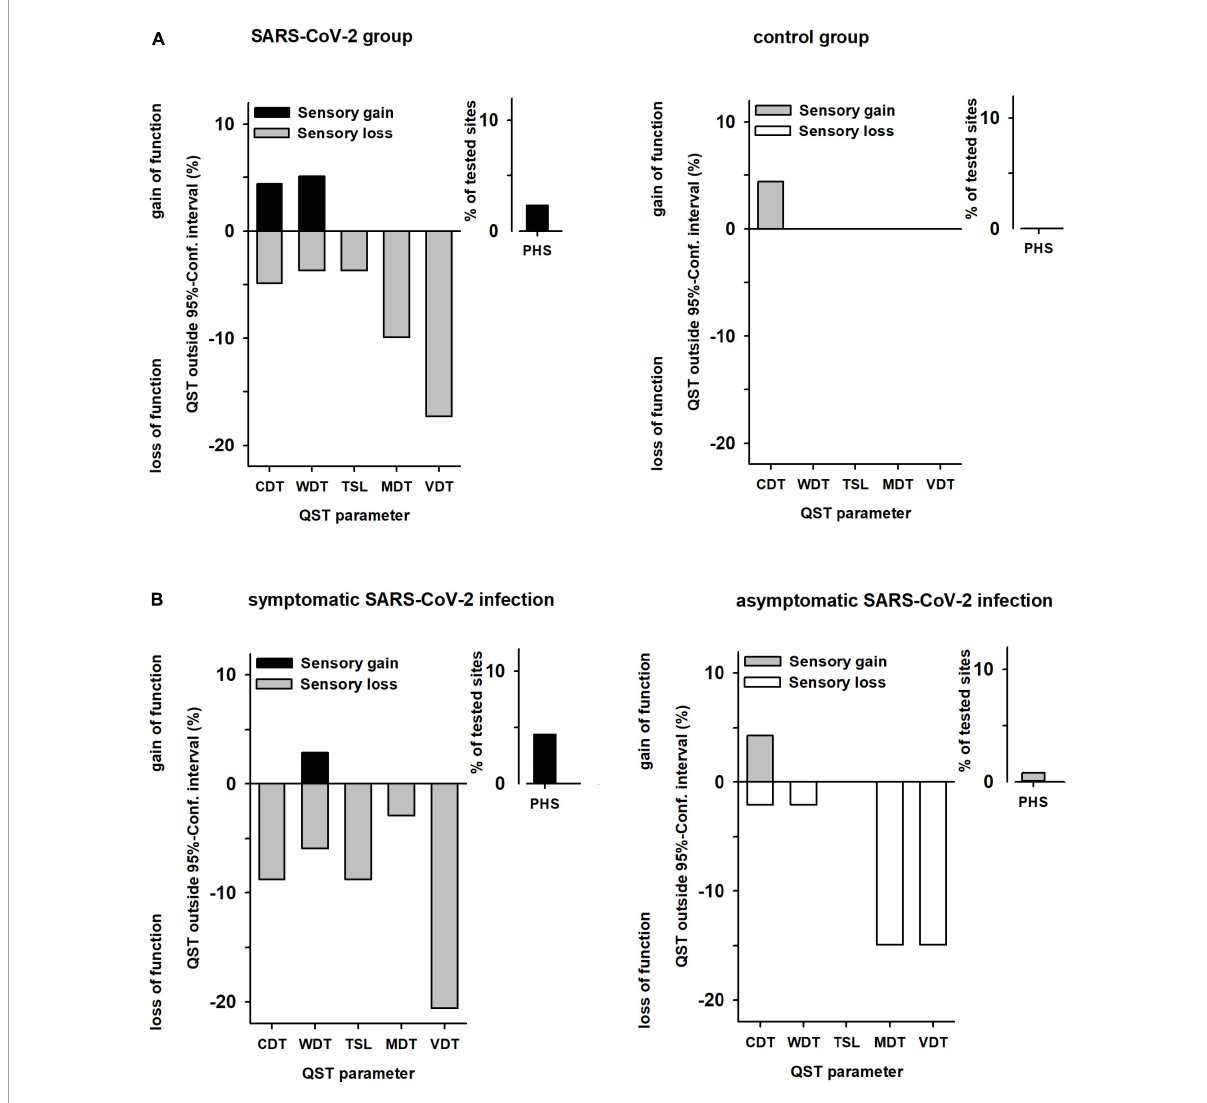
FIGURE3 Abnormal values of sensory parameters in (A) patients vs. controls and (B) patients with symptomatic vs. patients with asymptomatic SARS-CoV-2 infection. QST values outside the 95% confidence interval (95% CI) of the reference data base (13). The y -axis shows percentage of subjects, with positive sensory signs mapped upward (gain of sensory function) and negative sensory signs mapped downward (loss of sensory function). (A) Patients n = 82, Controls n = 38. (B) Patients with symptomatic SARS-CoV-2 n = 35, Patients with asymptomatic SARS-CoV-2 n = 47. Absence of paradoxical heat sensations (PHS) is normal, so there are no negative signs for PHS. QST, quantitative sensory testing; CDT, cold detection threshold; WDT, warm detection threshold; TSL, thermal sensory limen; MDT, mechanical detection threshold; VDT, vibration detection threshold; PHS, paradoxical heat